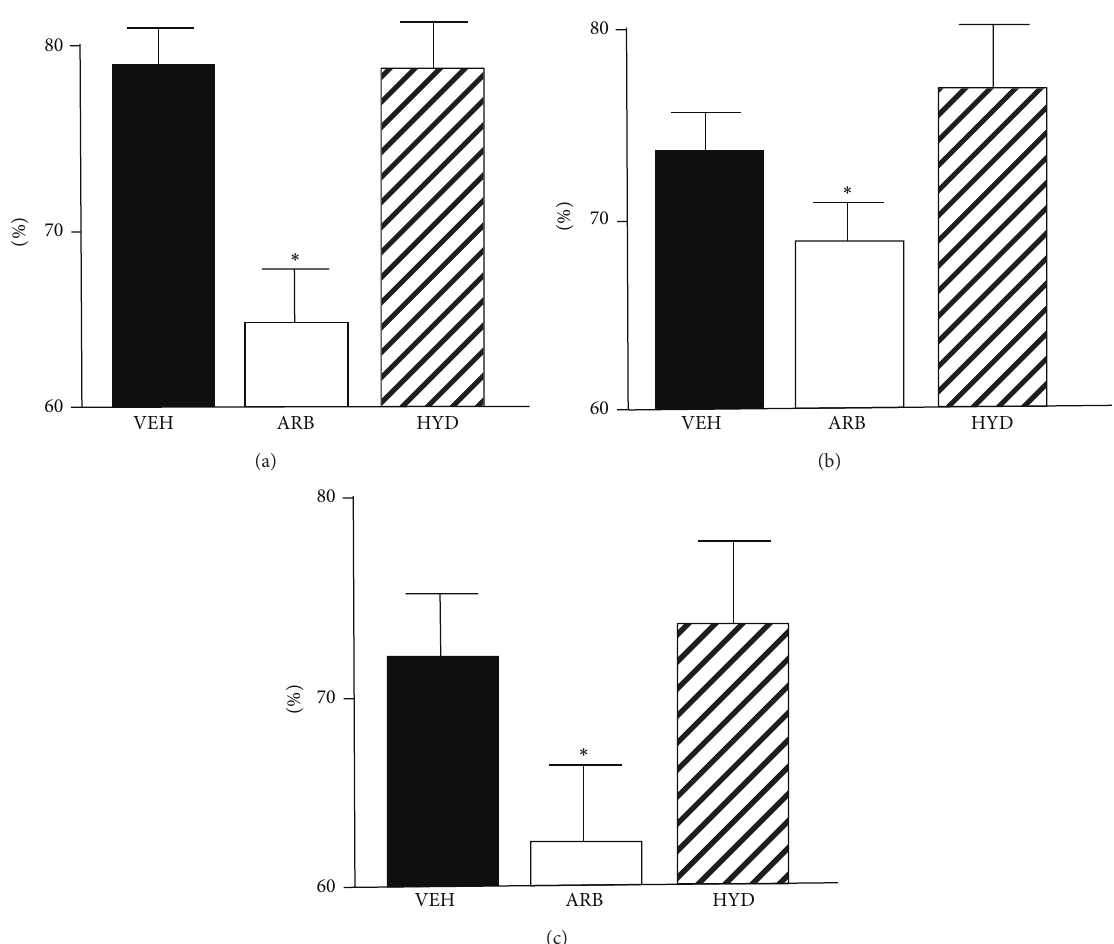
Figure 3: Normalized unit of the low-frequency component of systolic blood pressure as parameters 𝑓 sympathoexcitation in stroke-prone spontaneously hypertensive rats treated with intracerebroventricular infusion of losartan (ARB, 𝑛 = 5 ), oral-administered hydralazine (HYD, 𝑛 = 5 ), and intracerebroventricular infusion of vehicle (VEH, 𝑛 = 5 ) at early morning (a), after morning (b), and night (c). ∗ 𝑃 < 0.05 versus